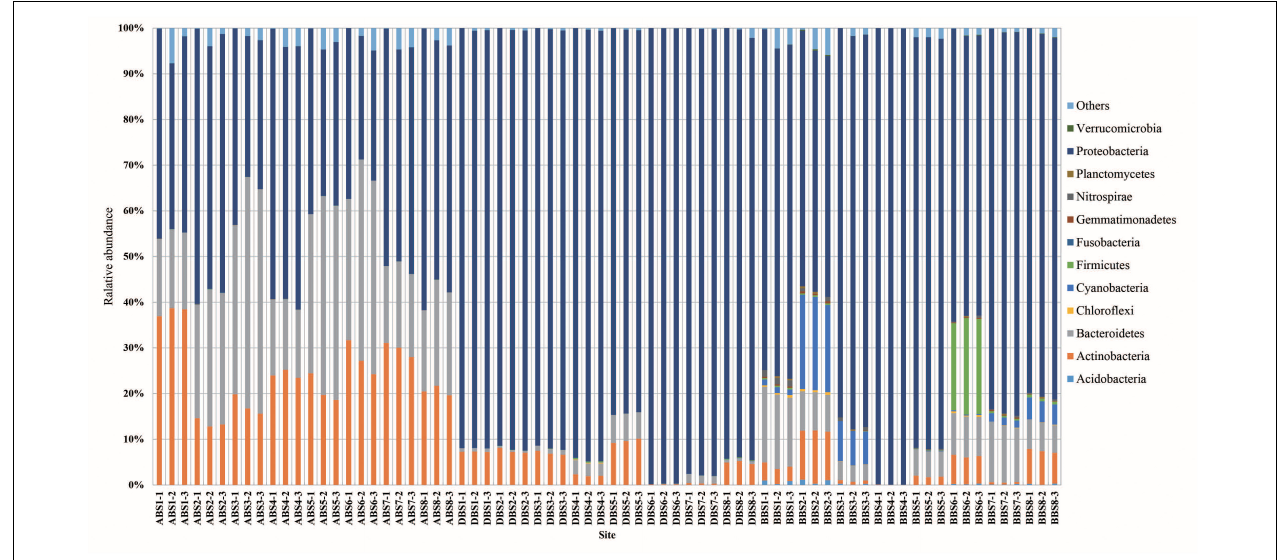
FIGURE 1 | The relative abundances of bacterial communities at the phylum level during the P. globosa blooms. BB, before P. globosa blooms; DB, during P. globosa blooms; AB, after P. globosa blooms.